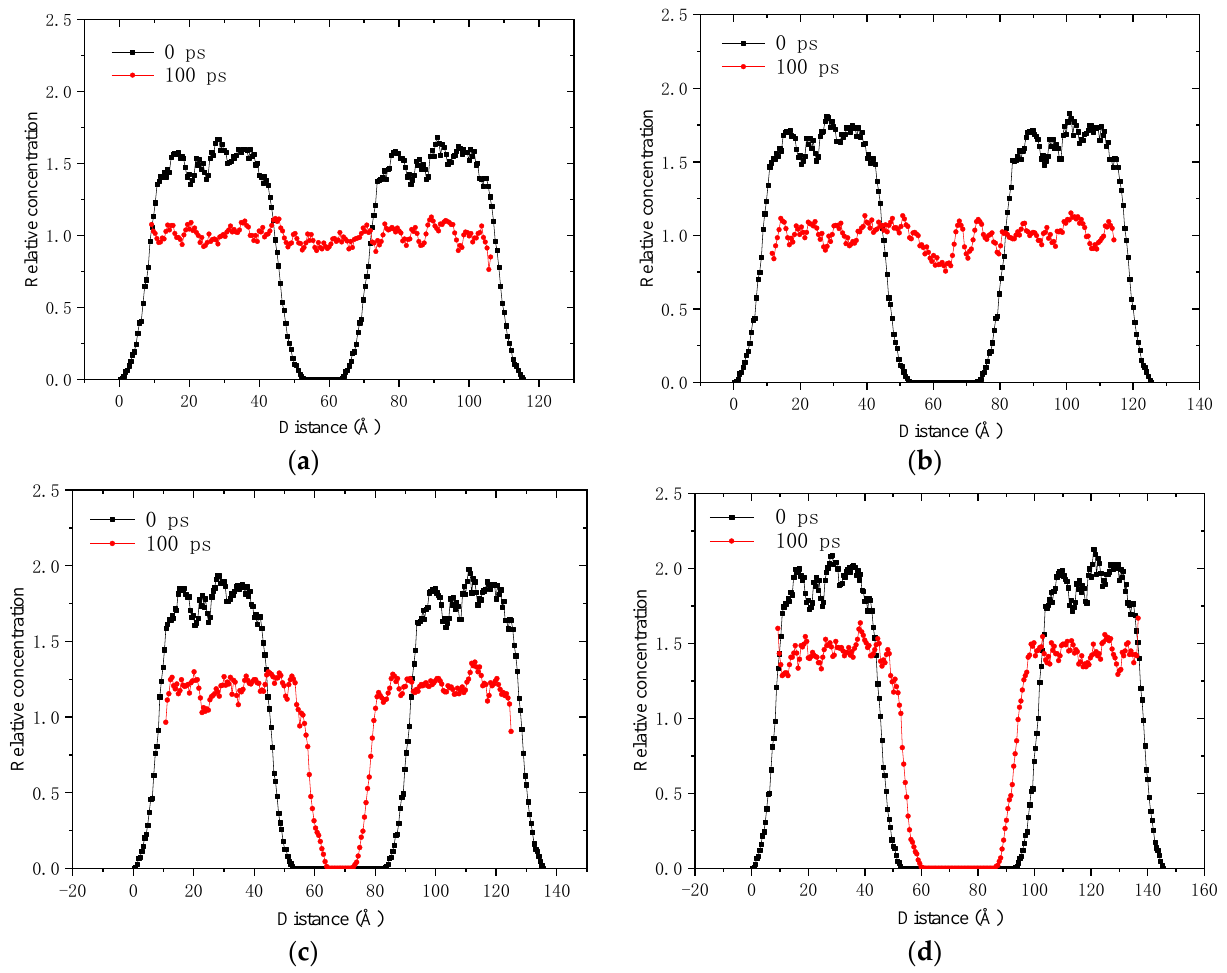
Figure 8. Relative concentration distribution curve along the z axis of the self-healing model of aged asphalt binder with 1 – 4 nm crack: ( a ) 1 nm; ( b ) 2 nm; ( c ) 3 nm; ( d ) 4 nm.